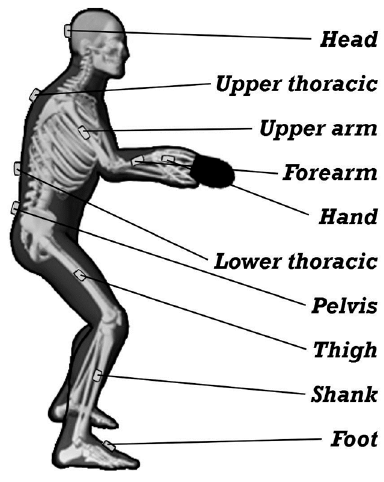
Figure 2. Sensor location.